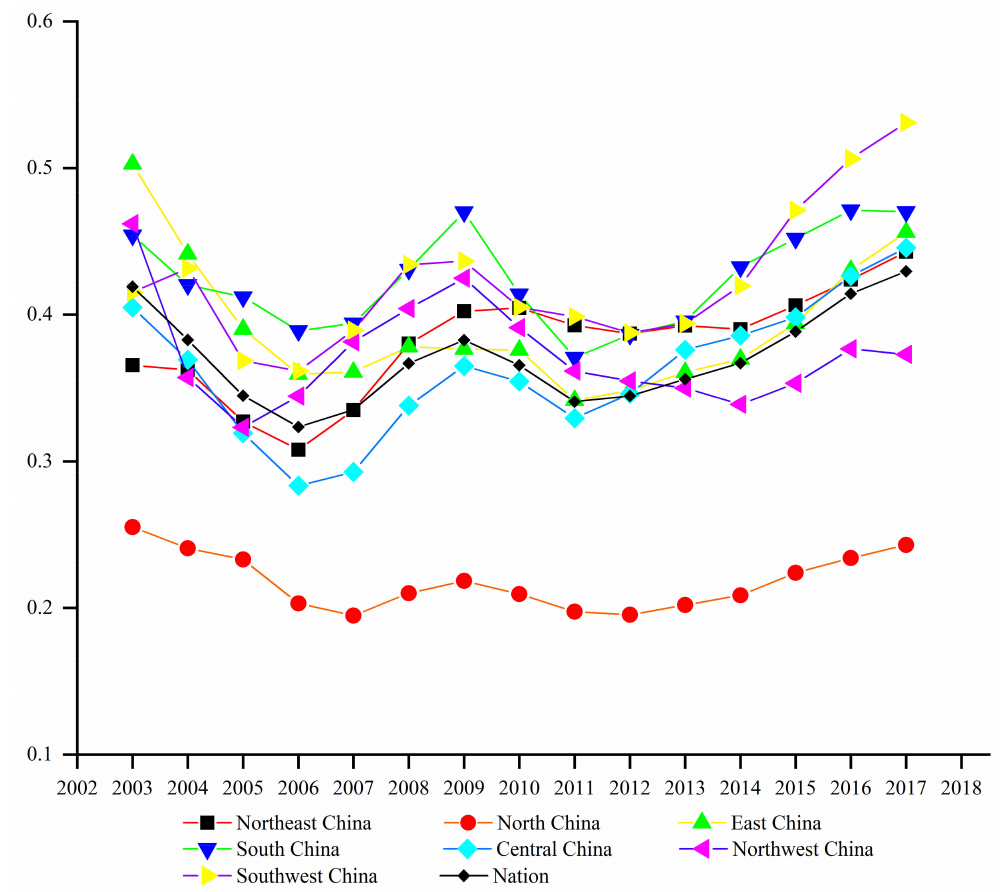
Figure 2. Temporal variations in average city-level CE from 2003 to 2017. From the regional perspective, the temporal trends of average CE in seven regions are consistent with the national level during the research period. However, there were significant regional differences. The lowest value region was North China, which was significantly lower than the national average level. However, the CE of Southwest China, South China, and East China is higher than the national average level. The efficiency of South China was higher and was surpassed by Southwest China from 2015 to 2017.